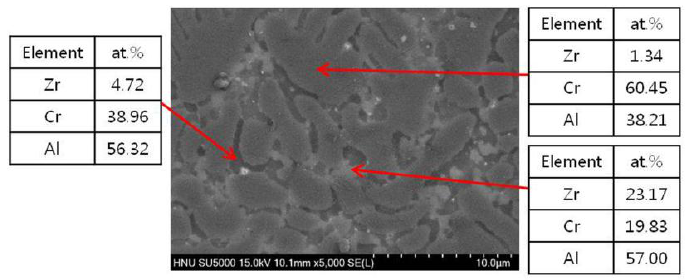
Figure 5. SEM-EDS analyses of CrAl coating layer on Zircaloy-4 alloy after the isothermal heating at 1100 °C for 2 h in inert atmosphere. 1100 ◦ C for 2 h in inert